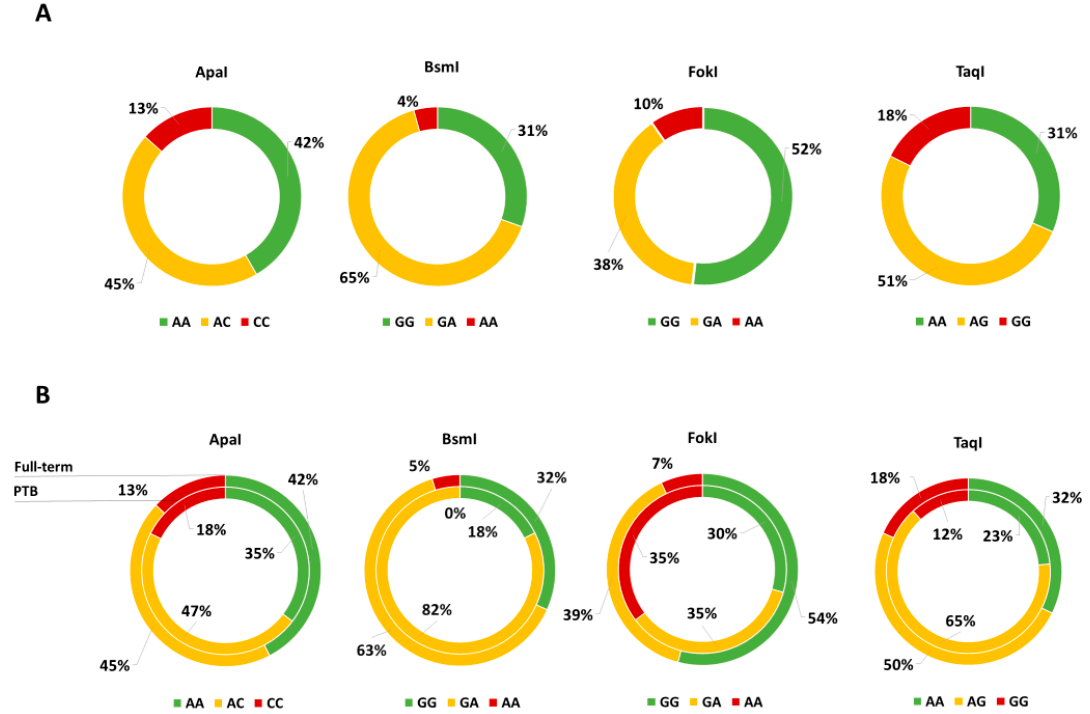
Figure 1. ( A ) Genotype Distribution of vitamin D receptor gene (VDR) Polymorphisms and comparison between preterm births (PTB, inner ring) and full-term births (outer ring). ( B ) comparison between preterm births (PTB, inner ring) and full-term births (outer